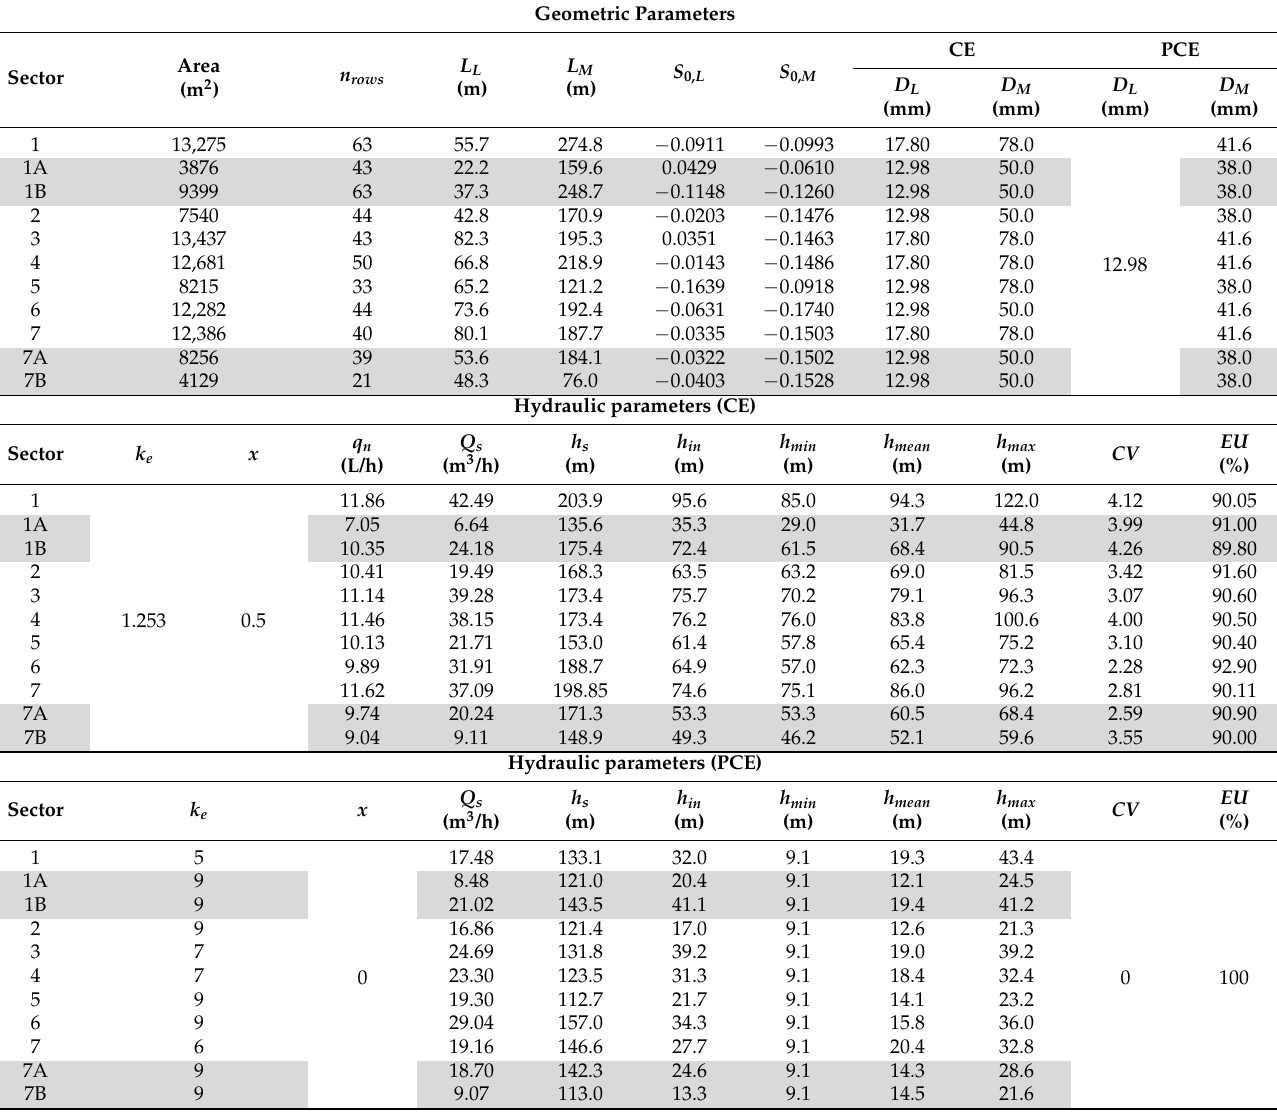
Table 7. Geometric and hydraulic design parameters for the farm subdivided into nine sectors, by splitting sectors #1 and #7 into two sectors (background colored), characterized by an “almost uniform” slope and planform geometry, designed by IRRIPRO, for common emitters (CE) and pressure compensating emitters (PCE). Geometric Parameters Sector